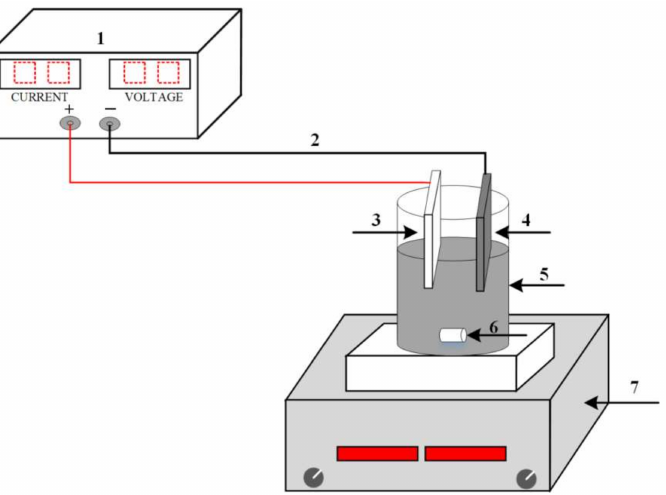
Figure 5. Electro-oxidation system for HMX wastewater treatment (1. DC power supply, 2. Copper wire, 3. Anode, 4. Cathode, 5. Electrolyte solution, 6. Rotor, 7. Magnetic